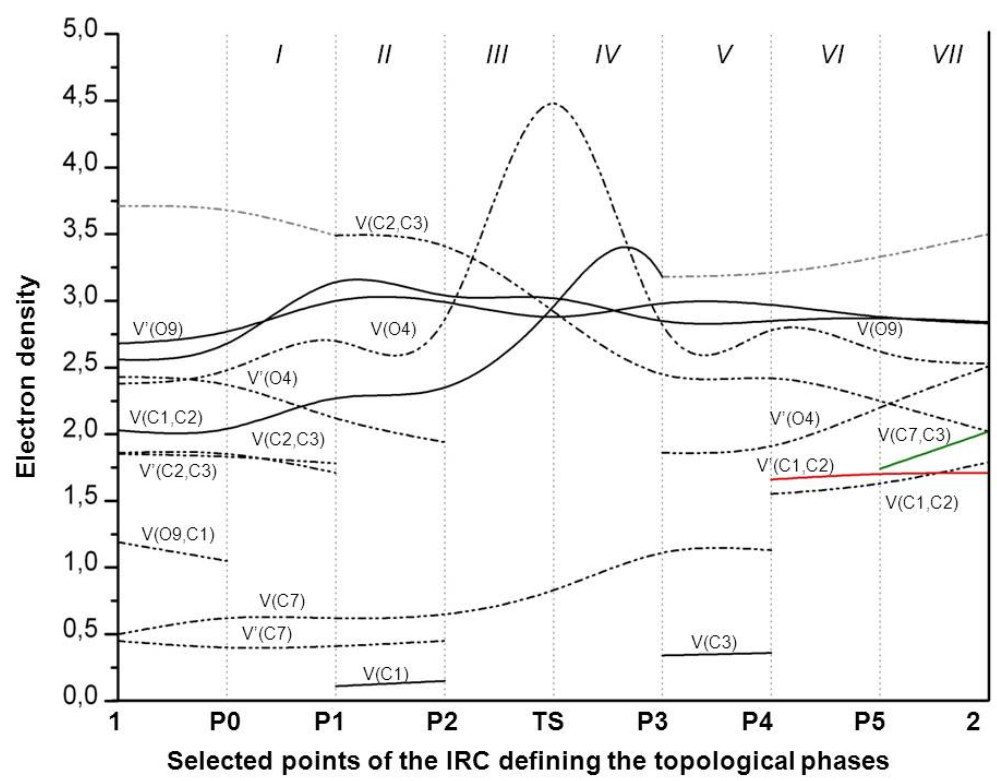
Figure 3. Graphical representation of the basin population changes during the rearrangement of nitronic ester 1 into nitronorbornene 2 . Point dotted curves in grey represent the sum of disynaptic basins describing a bond region or monosynaptic basins describing lone pairs.